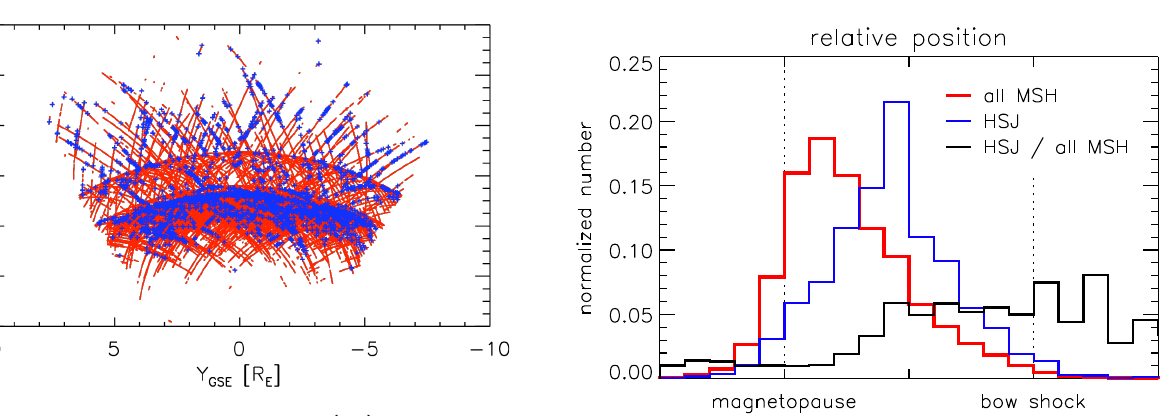
Fig. 3. Distributions of normalized radial distances of all magne- tosheath (MSH) observations (red, reference) and HSJ observations (blue) between model magnetopause and bow shock (models by Shue et al., 1998; Merka et al., 2005). The HSJ observation distri- bution normalized by the reference distribution is shown in